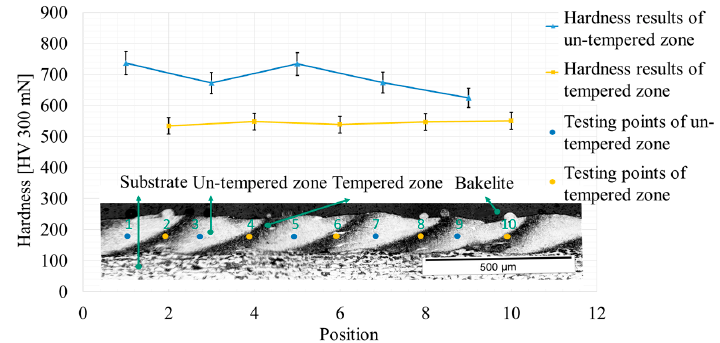
Figure 10. Hardness distribution within a single layer.